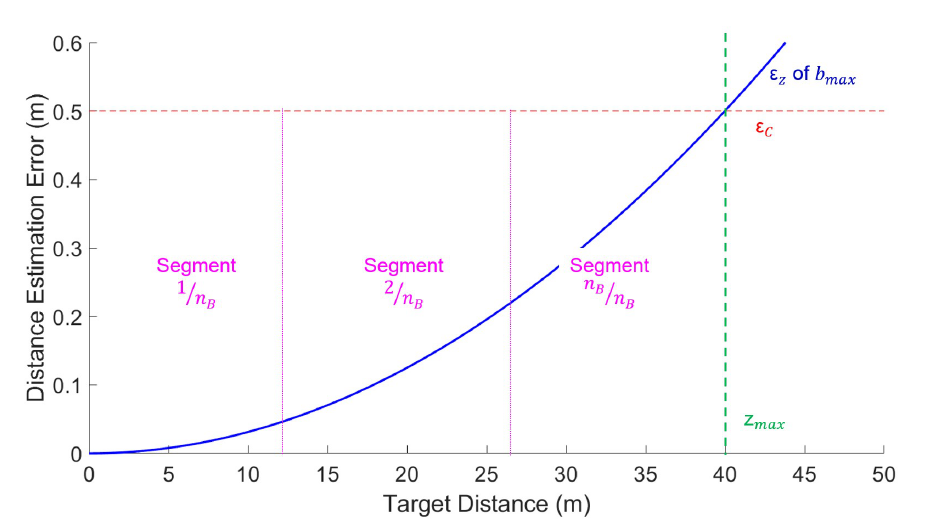
Figure 9. Graph of an example case of baseline fusion. x-axis is distance, while y-axis is depth estimation error in meters. This example case is the case where the given conditions are n B = 3, (cid:101) c = constant 0.5 m, z max = 40